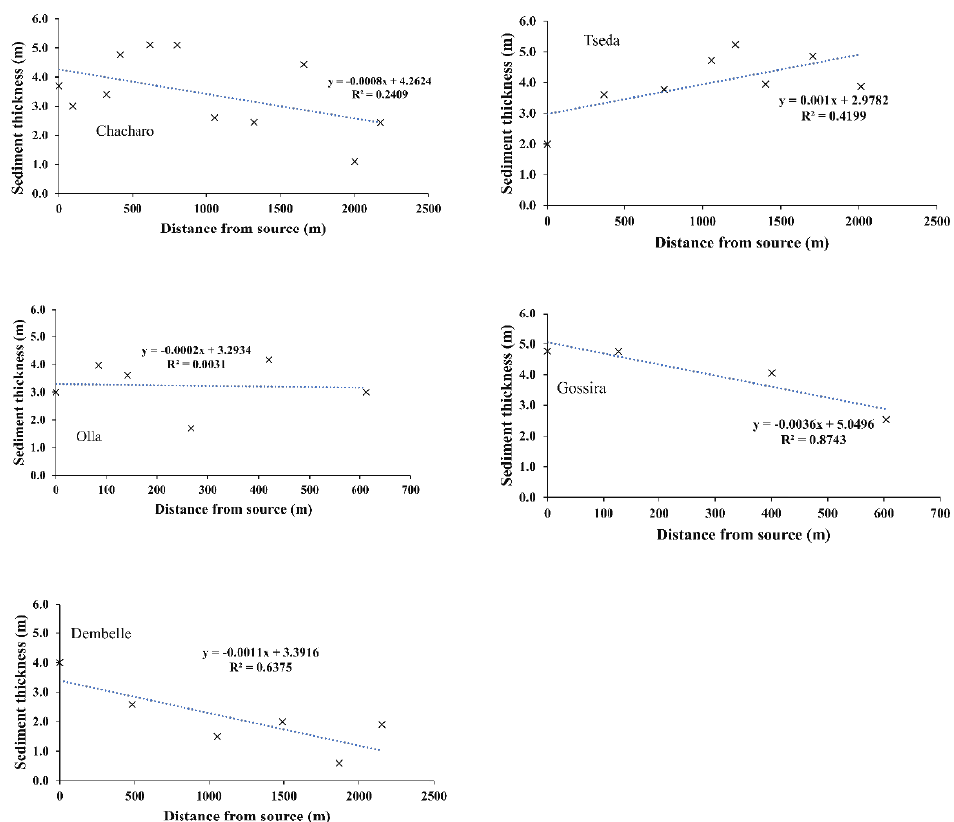
Figure 6. Average floodplain sediment thickness in relation to distance from the source of the river.